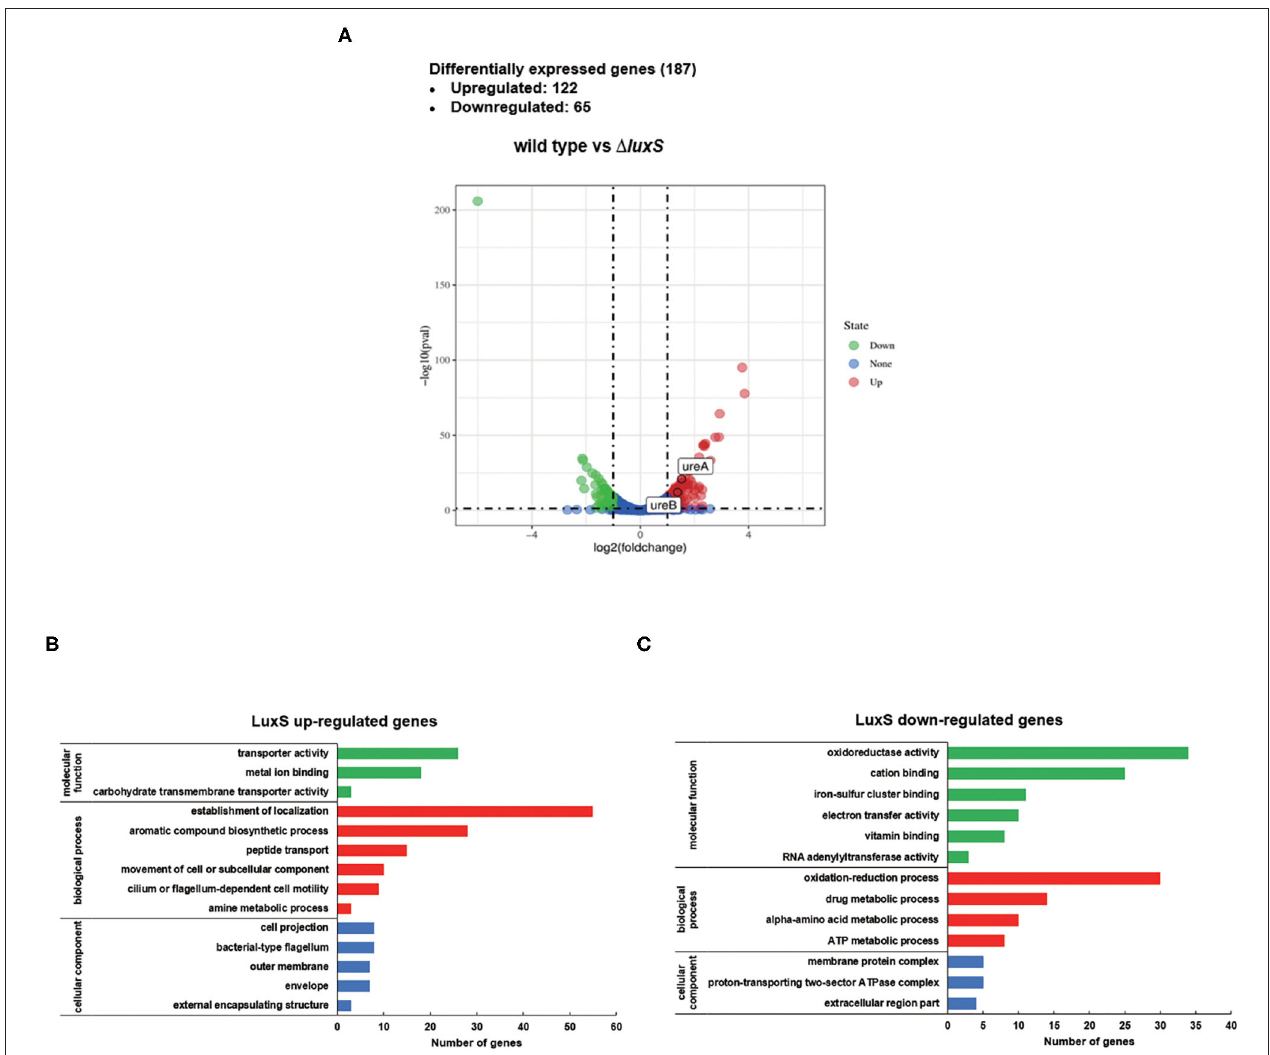
FIGURE 1 | Differentially expressed genes (DEGs) regulated by LuxS identified by RNA sequencing. (A) Volcano plot comparing gene transcripts from wild type and 1 luxS mutant strains of H. pylori . The dashed transverse line indicates where P-value = 0.05 and the two vertical dotted lines represent |log of |log 2 FoldChange| > 1 and P-value < 0.05 are highlighted in red (significantly upregulated) and green (significantly downregulated). ureA and ureB genes are mapped in upregulated regions. Functional classification of (B) LuxS-upregulated DEGs and (C) LuxS-downregulated DEGs based on transcriptomic profiling. The green, red, and blue bars represent DEGs classified as molecular function, biological process, and cellular component categories,